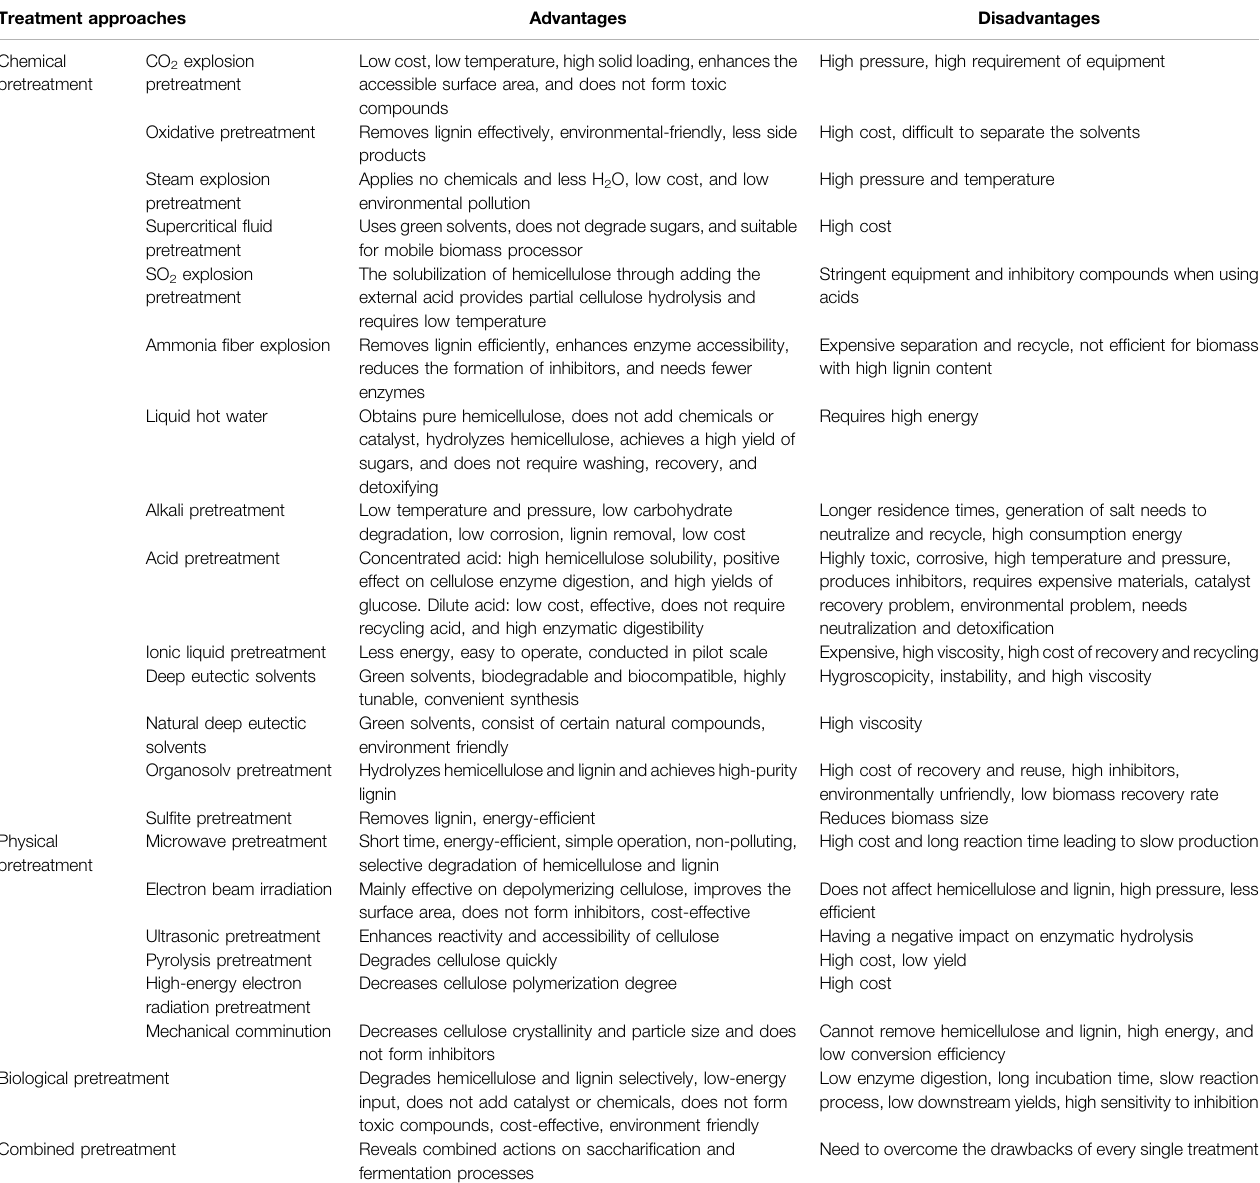
TABLE 5 | Advantages and disadvantages of diverse treatment approaches. Treatment